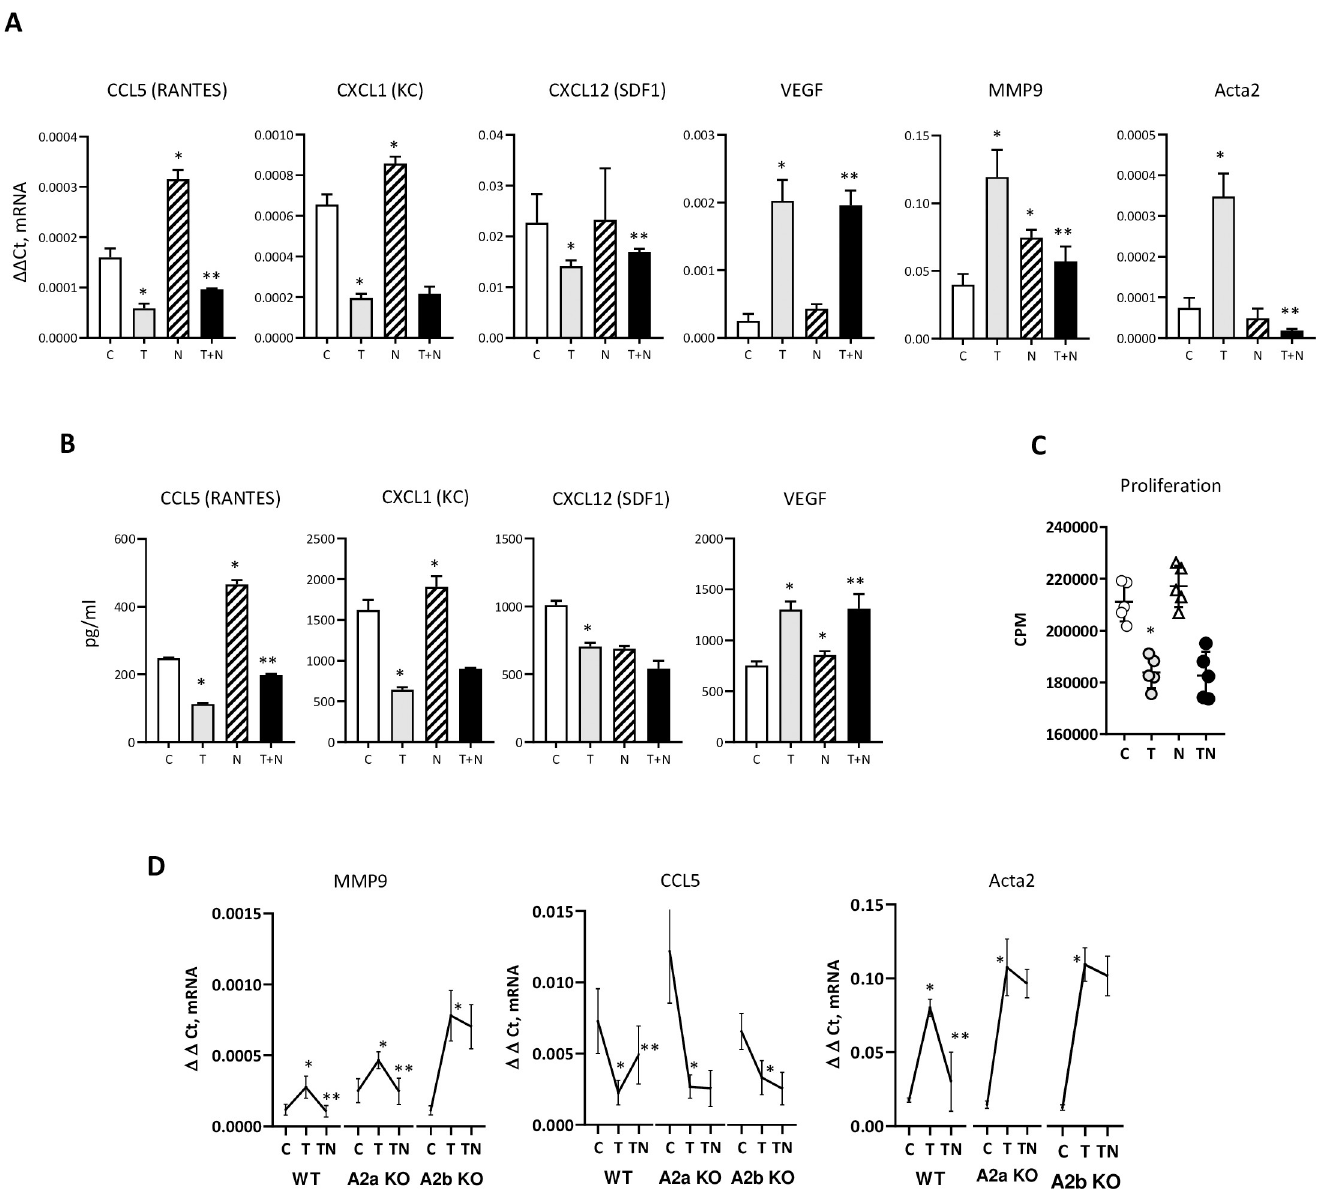
Fig 1. Effect of adenosine on TGF β dependent proteins. A ) qPCR analysis of immortalized mouse mammary fibroblasts. Graphs show Δ ct expression of CCL5 (RANTES) , CXCL1(KC) , VEGF , MMP9 , and α SMA . � —p < 0.05 vs. control (C) group, �� —p < 0.05 vs. TGF β (T) group. Mouse mammary fibroblasts were cultured with TGF β (1 ng/ml) and/or NECA (10 uM) for 18 hr. with following RNA isolation for qPCR analysis. B ) Secreted protein measurement by ELISA. Cells (5x10 5 ) in 6 wells plate/3 ml of medium were cultured overnight. � —same as in A. C ) Proliferation assay (thymidine-[H3]) of mouse mammy fibroblasts. Graph shows CPM counts. Mouse mammy fibroblasts were cultured 24 hr. with TGF β (1 ng/ml) and/or NECA (10 uM) and presence of 1 uCi. C- control, T–TGF β , N–NECA, T+N– TGF β + NECA. D ) qPCR analysis of primary mouse mammary fibroblasts isolated from mouse mammary gland of WT and A2a-KO, and A2b-KO animals. Graphs show Δ ct expression of CCL5 (RANTES), MMP9 , and α SMA . Primary mouse mammary fibroblast isolated by FACS sorting as CD104a + (CD45 - CD326 - ) cells. Cells were used in passage 1 and incubated with TGF β and/or